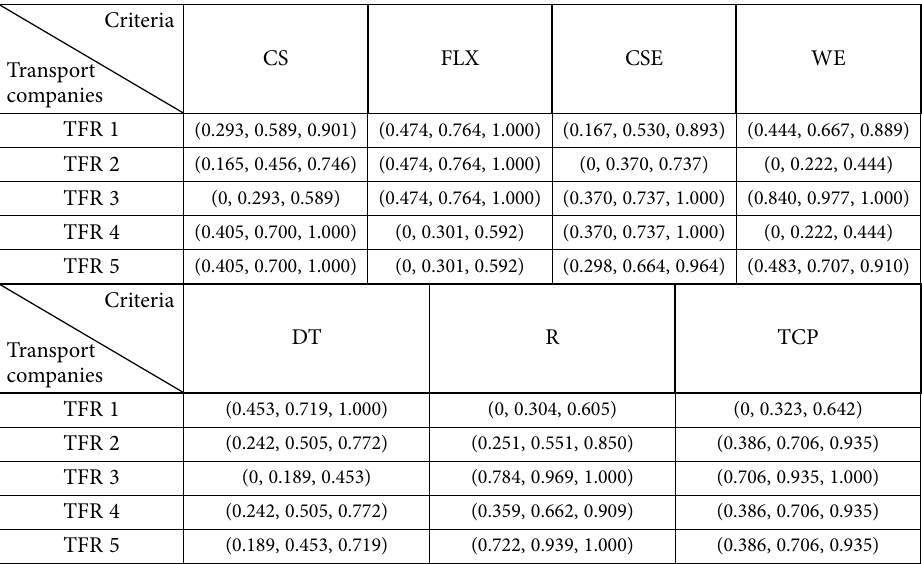
Table 12. The fuzzy normalized decision matrix